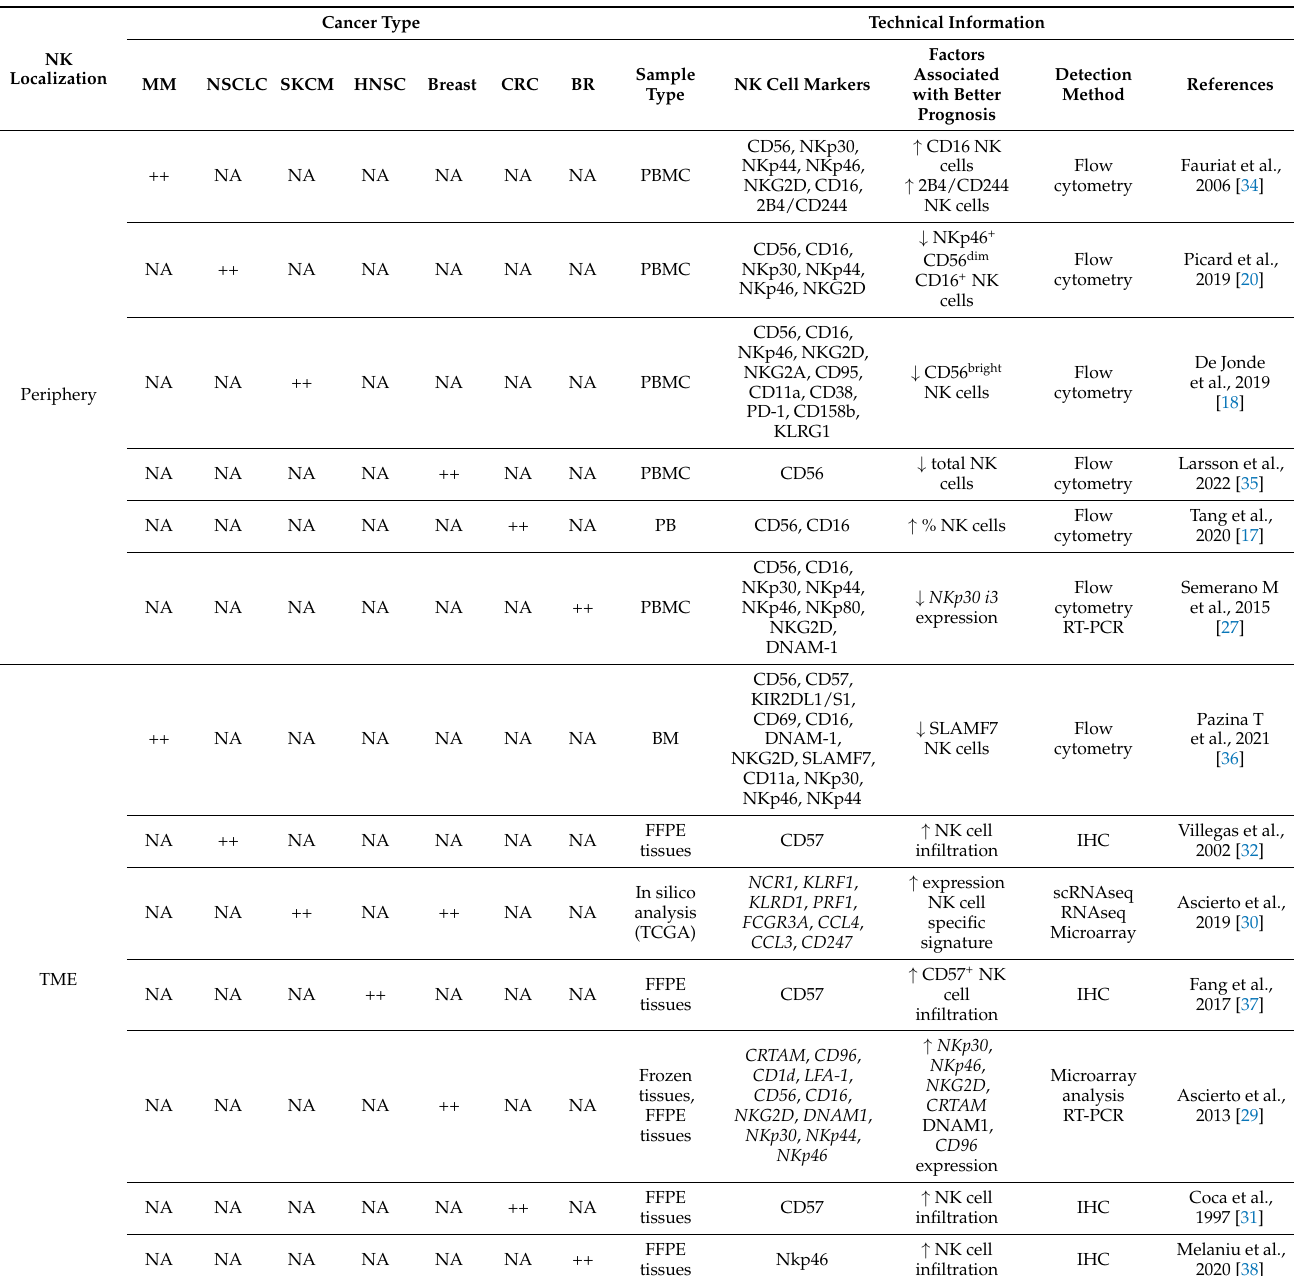
Table 1. Summary of selected clinical studies assessing the relationship between circulating and infiltrated NK cells and the clinical outcome in different selected cancer types. MM: multiple myeloma; NSCLC: non-small cell lung cancer; SKCM: skin cutaneous melanoma; HNSC: head and neck squamous cell carcinoma; breast; CRC: colorectal cancer; BR: brain tumors. ++: very positive association; +: positive association; NA: not applicable; BM: bone marrow; FFPE: formalin-fixed paraffin-embedded; IHC: immunohistochemistry; PB: peripheral blood; PBMC: peripheral blood mononuclear cells; TCGA: the cancer genome atlas. ↑ increased number of selected cells; ↓ reduced number of selected